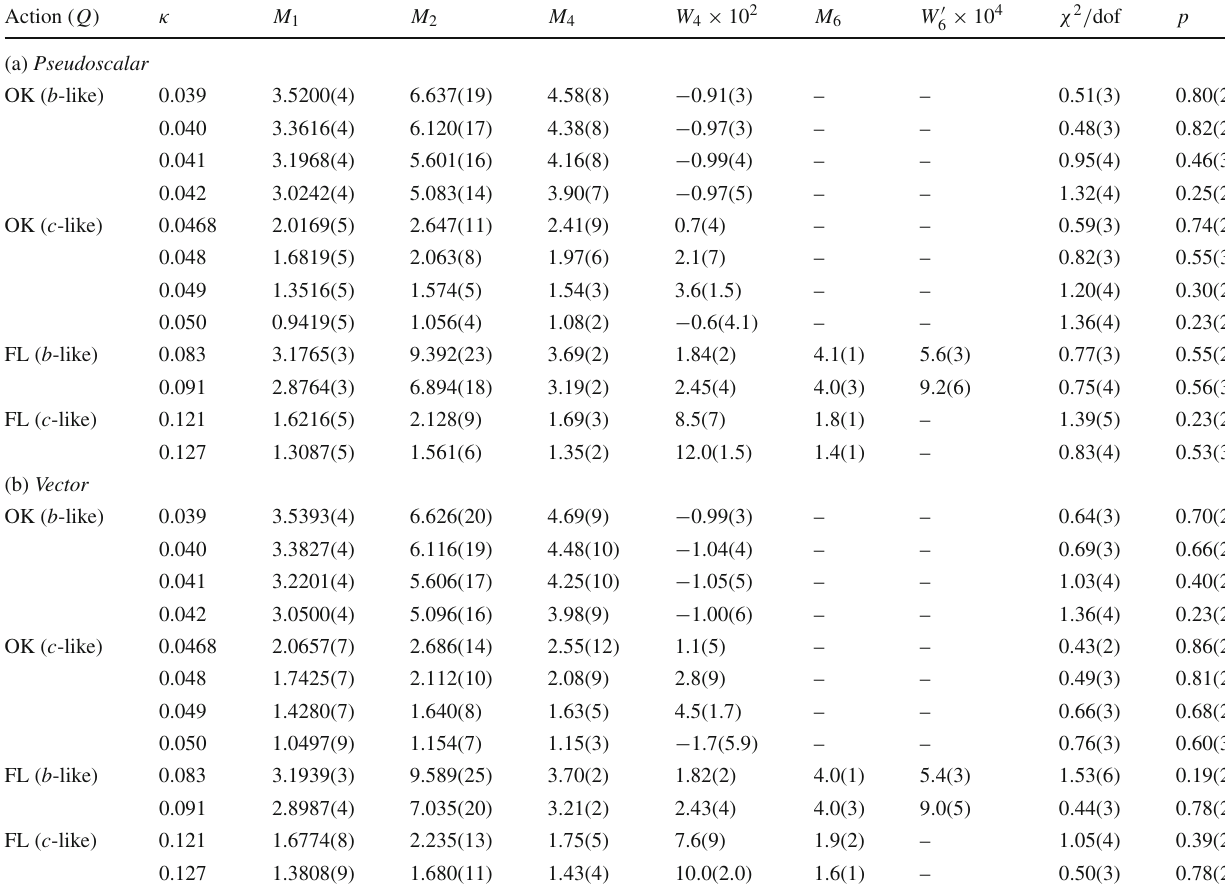
Table 5 Dispersion fit results for quarkonium. The energies E are from the correlator fits to the function in Eq. (30). The first column indicates the lattice action and the (approximate) heavy-quark flavor. The sec- ond column is the hopping parameter κ . The following columns are the rest mass M 1 , the kinetic mass M 2 , the generalized masses M 4 and M 6 , and the coefficient of an O ( 3 ) symmetry breaking terms W 4 and W (cid:12) . The last two columns are the χ 2 divided by the degrees of 6